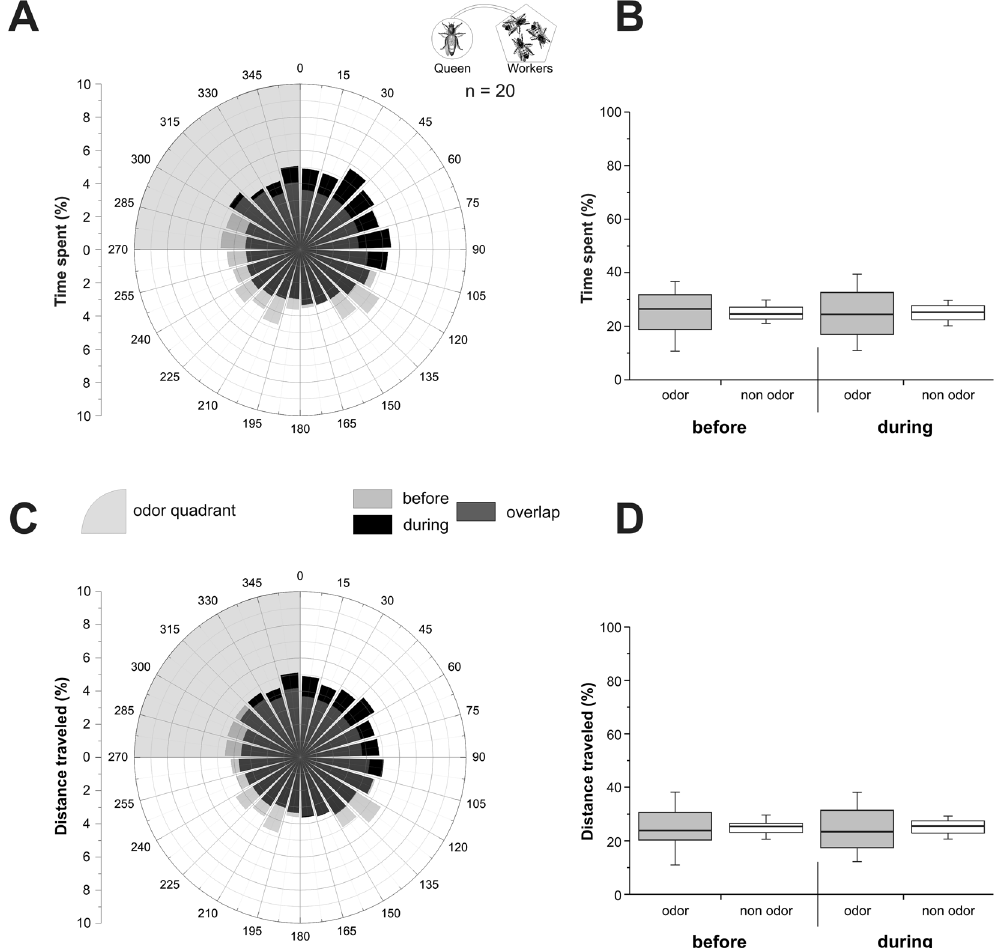
Figure 3. Experiment 2: virgin queens’ response to worker odour bouquet. Virgin queens’ behaviour on the walking simulator, when stimulated with the odour bouquet of 10 workers. ( A , C ) Circular histograms showing the percentage of time spent ( A ) or of distance travelled ( C ) by virgin queens according to 15° sectors, with the odour quadrant being represented on the upper left (grey area). Light grey bars represent the 5 min before odour stimulation (‘before’), black bars represent the 5 min during stimulation (‘during’), and hence, dark grey bars show the overlap of the two phases. ( B , D ) Histograms of the percentage of time spent ( B ), or of distance travelled ( D ) by virgin queens in the odour quadrant (gray box) and on average in the three odourless quadrants (white box) before and during odour